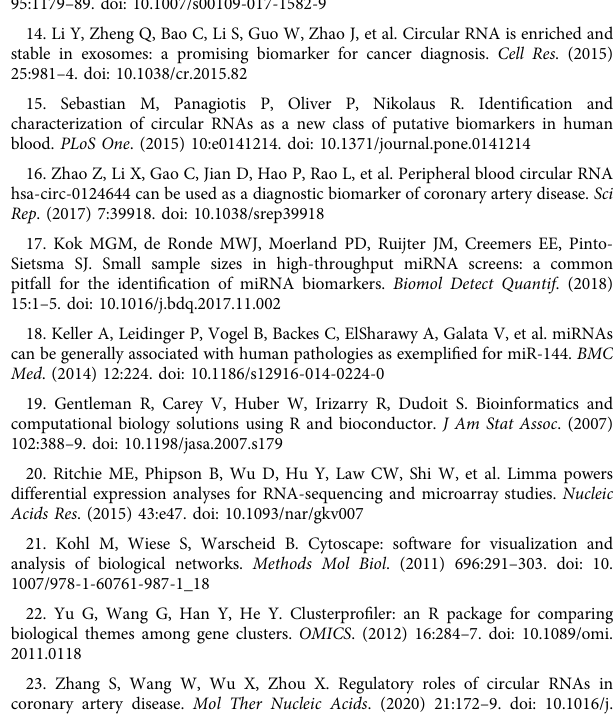
SUPPLEMENTARY TABLE 1 The analysis for differentiallyexpressed miRNAs. SUPPLEMENTARY TABLE 2 The analysis for Gene Ontology. SUPPLEMENTARY TABLE3 The analysis for KEGG